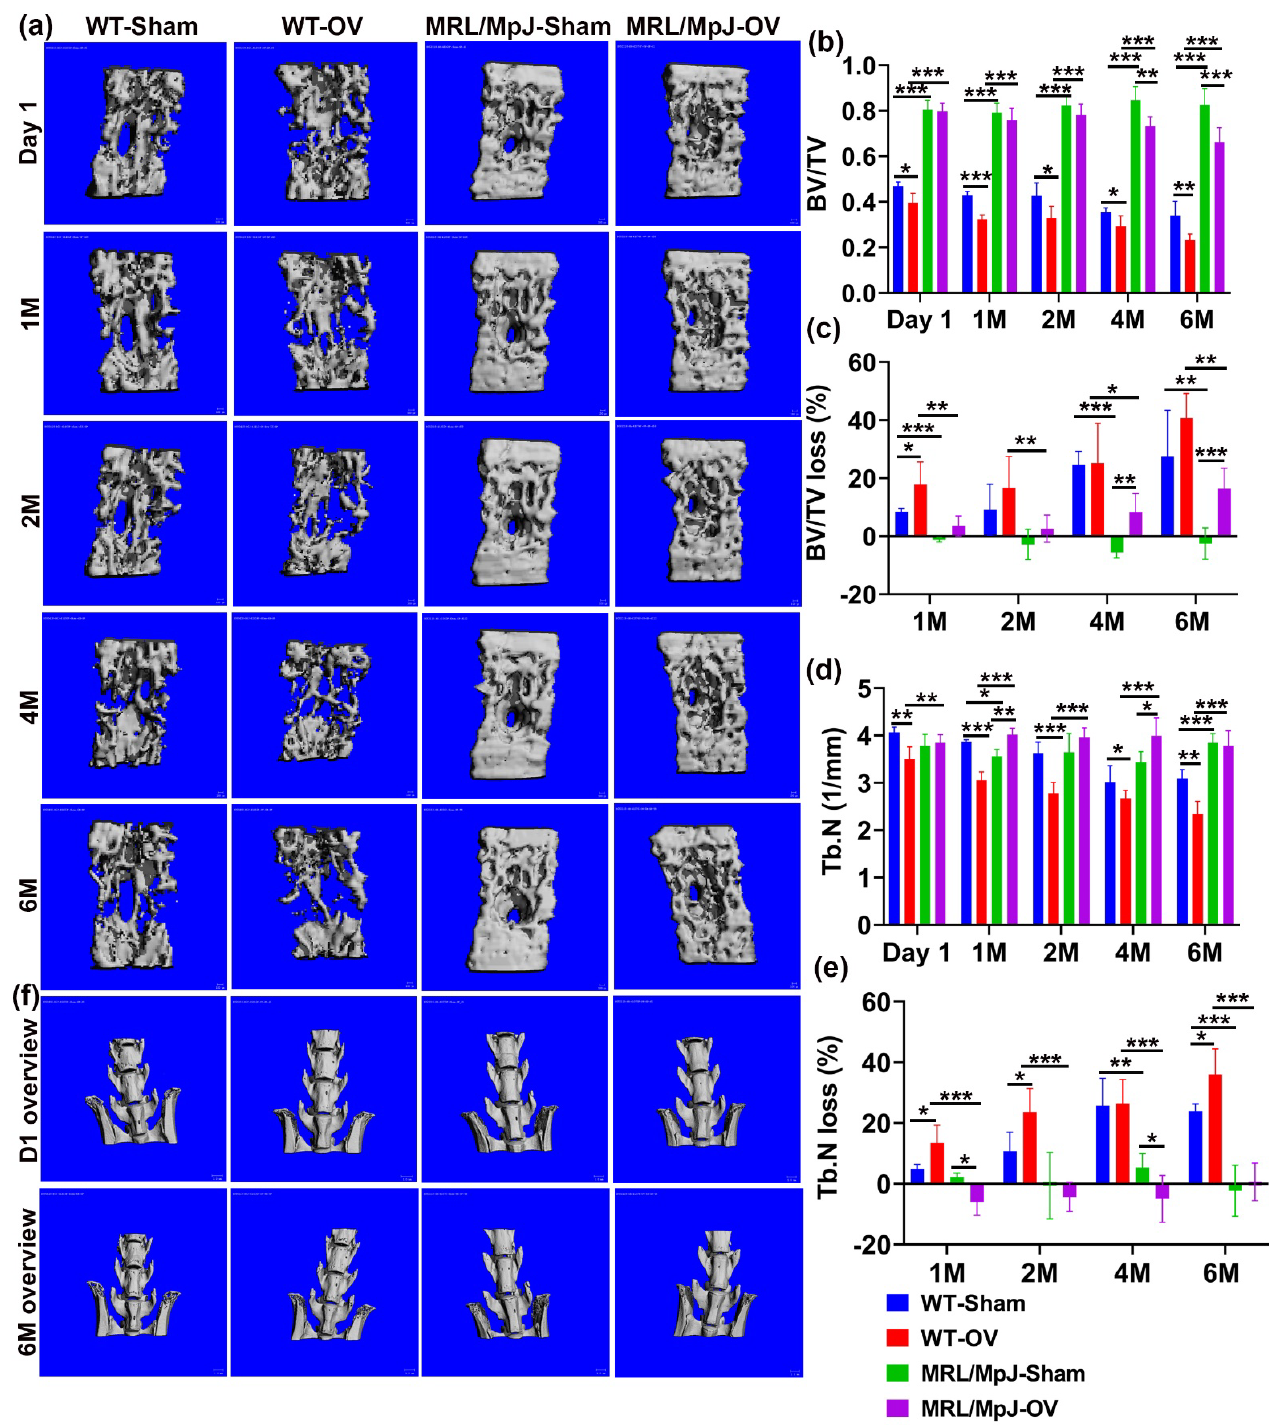
Figure 5. MicroCT analysis of spine L6 trabecular bone over the course of 6M after ovariectomy. ( a ) Micro-CT 3D images of spine L6 at different timepoints after surgery. MRL/MpJ-Sham and MRL/MpJ-OV mice showed markedly higher trabecular bone mass than WT-Sham and WT-OV, respectively, at different timepoints after surgery. Scale bars = 100 µ m. ( b ) BV/TV. The BV/TV of the WT-OV mice progressively decreased over the 6M period and was significantly lower than WT-Sham mice at day 1, 1M, 2M, 4M, and 6M. MRL/MpJ-OV mice showed significantly decreased BV/TV compared to MRL/MpJ-Sham mice only at 4M and 6M. MRL/MpJ-OV and MRL/MpJ-Sham mice showed significantly higher BV/TV than those of their WT counterparts, respectively, at all timepoints. ( c ) BV/TV loss percentage. Both WT-Sham and WT-OV mice showed BV/TV losses at 1 M,